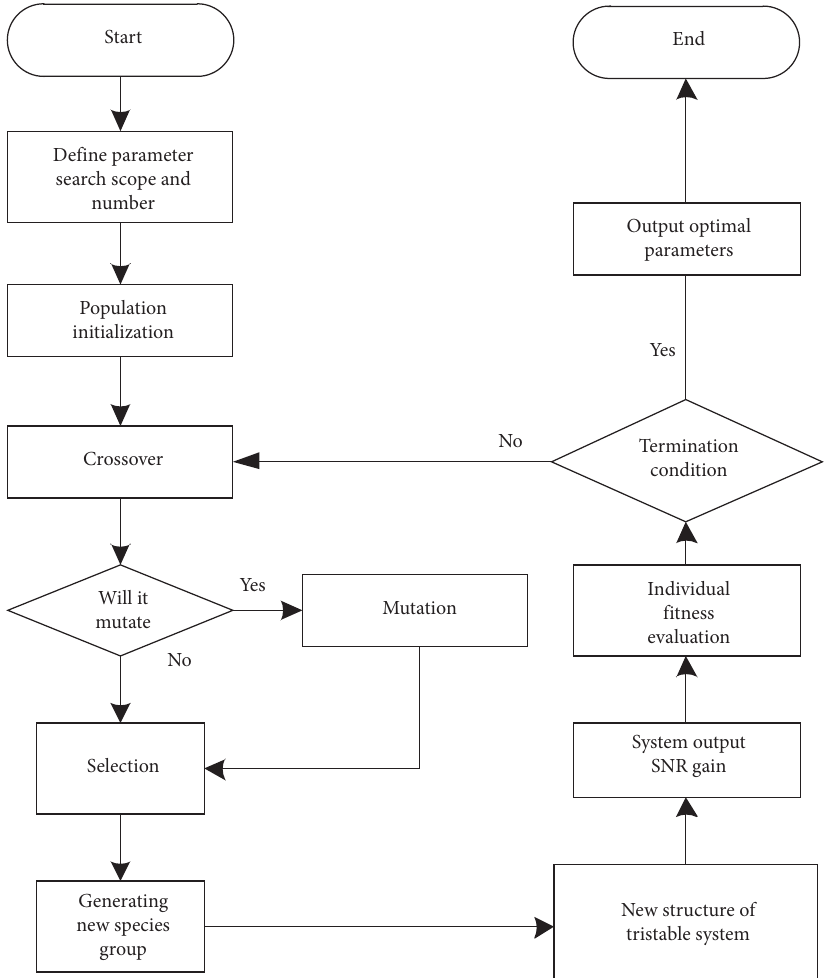
Figure 7: Flow chart of genetic